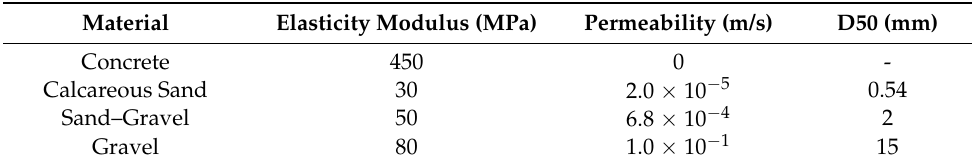
Table 2. Mechanical parameters of the materials used in the physical model.